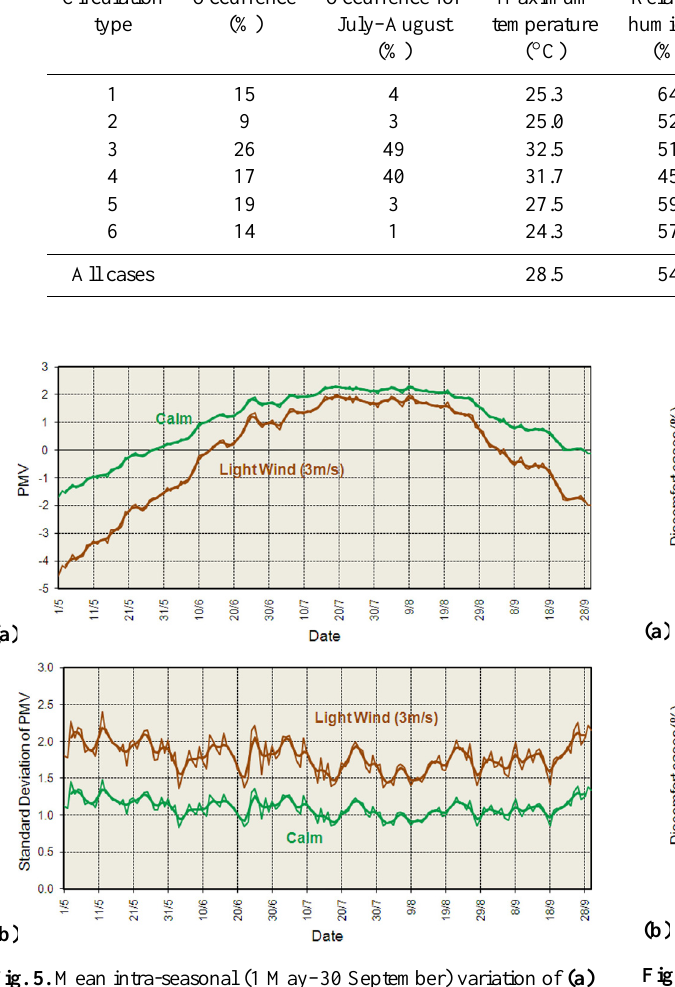
Fig. 5. Mean intra-seasonal (1 May–30 September) variation of (a) PMV and (b) PMV standard deviation in Athens at 14:00 for calm and light wind conditions for the period 1954–2012 (smoothing as in Fig. 1).